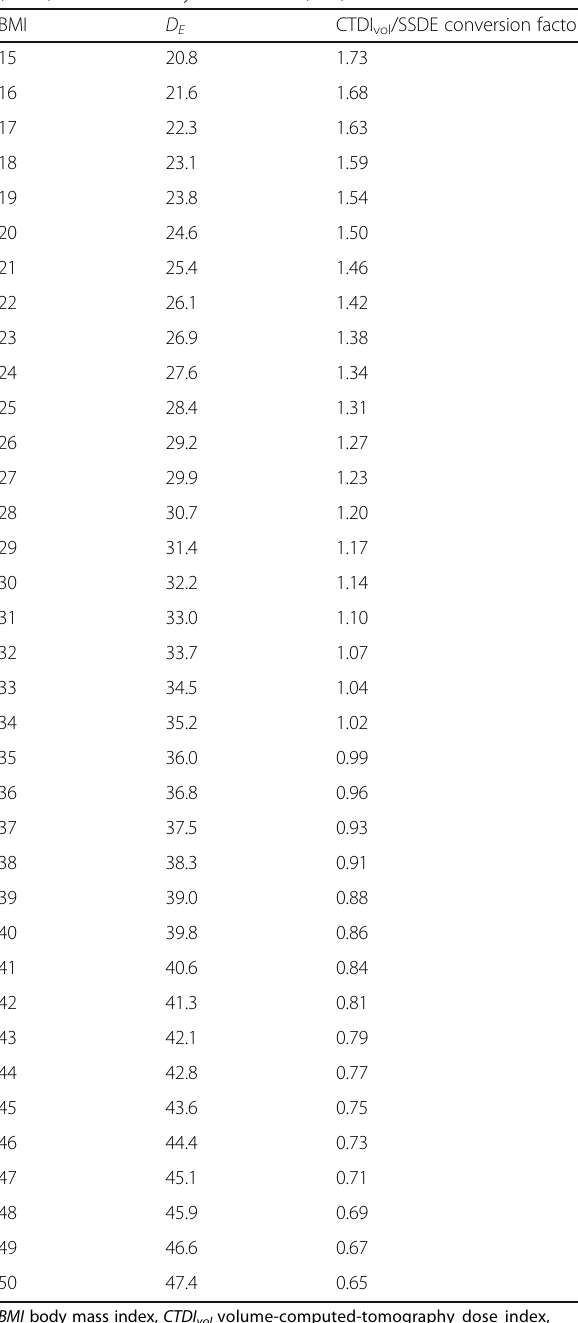
Table 3 Conversion factors to convert volume-computed- tomography dose index (CTDI vol ) to size-specific dose